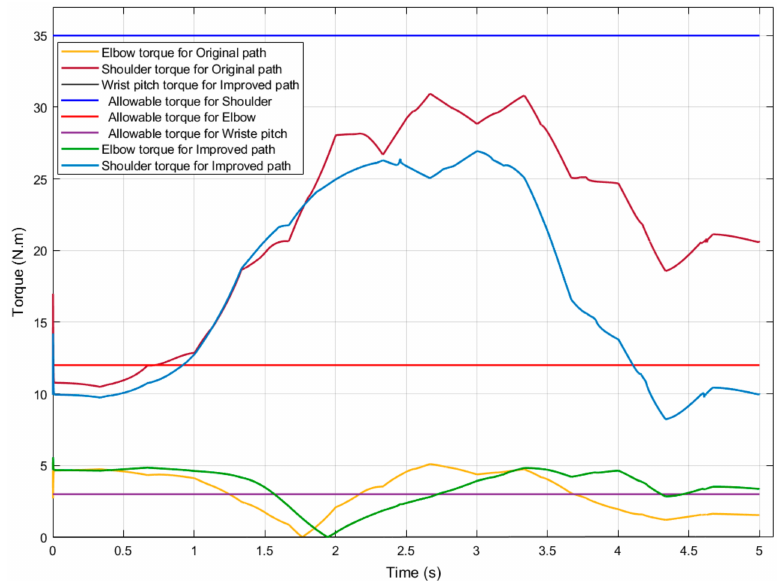
Figure 16. Variation of joint torques according to the two paths, ct = 5